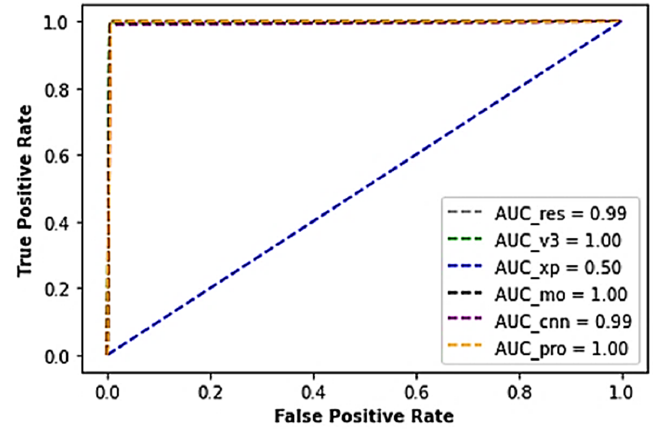
Figure 7. A cross-section of the AUC-ROC results of the industrial casting dataset. A breakdown of the outcome of each of the learner models and the voted model using the submersible pump impeller casting dataset (see the confusion matrix table in Figures 8 and 9), shows that the built typical CNN model correctly classified all the 452 submers- ible pump impeller casting test samples as non-defect, except one sample misclassified as a defected sample. The model also identified all the defect test samples without any mis- take, thereby yielding an overall superior performance against the other models. All the models yielded good results with negligible misrecognition except the InceptionV3, which misclassified four test samples belonging to the non-faulty class as faulty and the MobileNet, which misrecognized four samples as defected samples instead of non-defect samples.